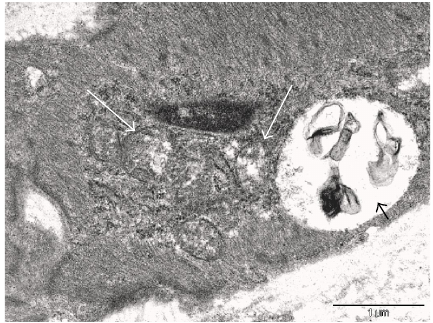
Figure 12: Injury and autophagy. A cluster of degenerating mito- chondria (long arrows) near the center of the image are swollen and show fragmentation and loss of cristae. The myofilaments of the surrounding cytoplasm also appear granular and degenerate. To the right of the mitochondria, there is vacuole, probably autophagic, containing membranous debris (short arrow). The image suggests thatthedegeneratemitochondriaandmyofilamentsarebeingdrawn into an autophagic vacuole. Original magnification: